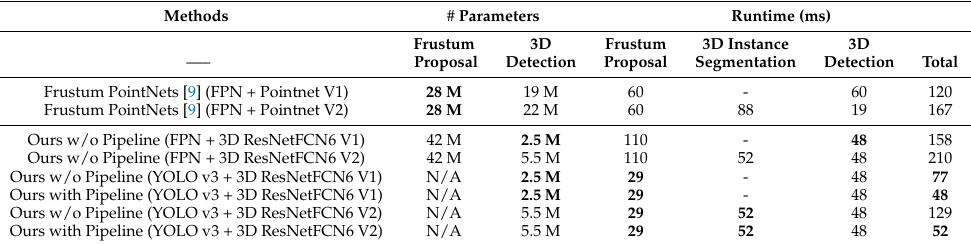
Table 11. Number of parameters and inference time comparison between Frustum Pointnet and our systems V1 and V2. For YOLO v3, input resolution is 416 by 416 and the model FLOPS is 65.86 Bn.